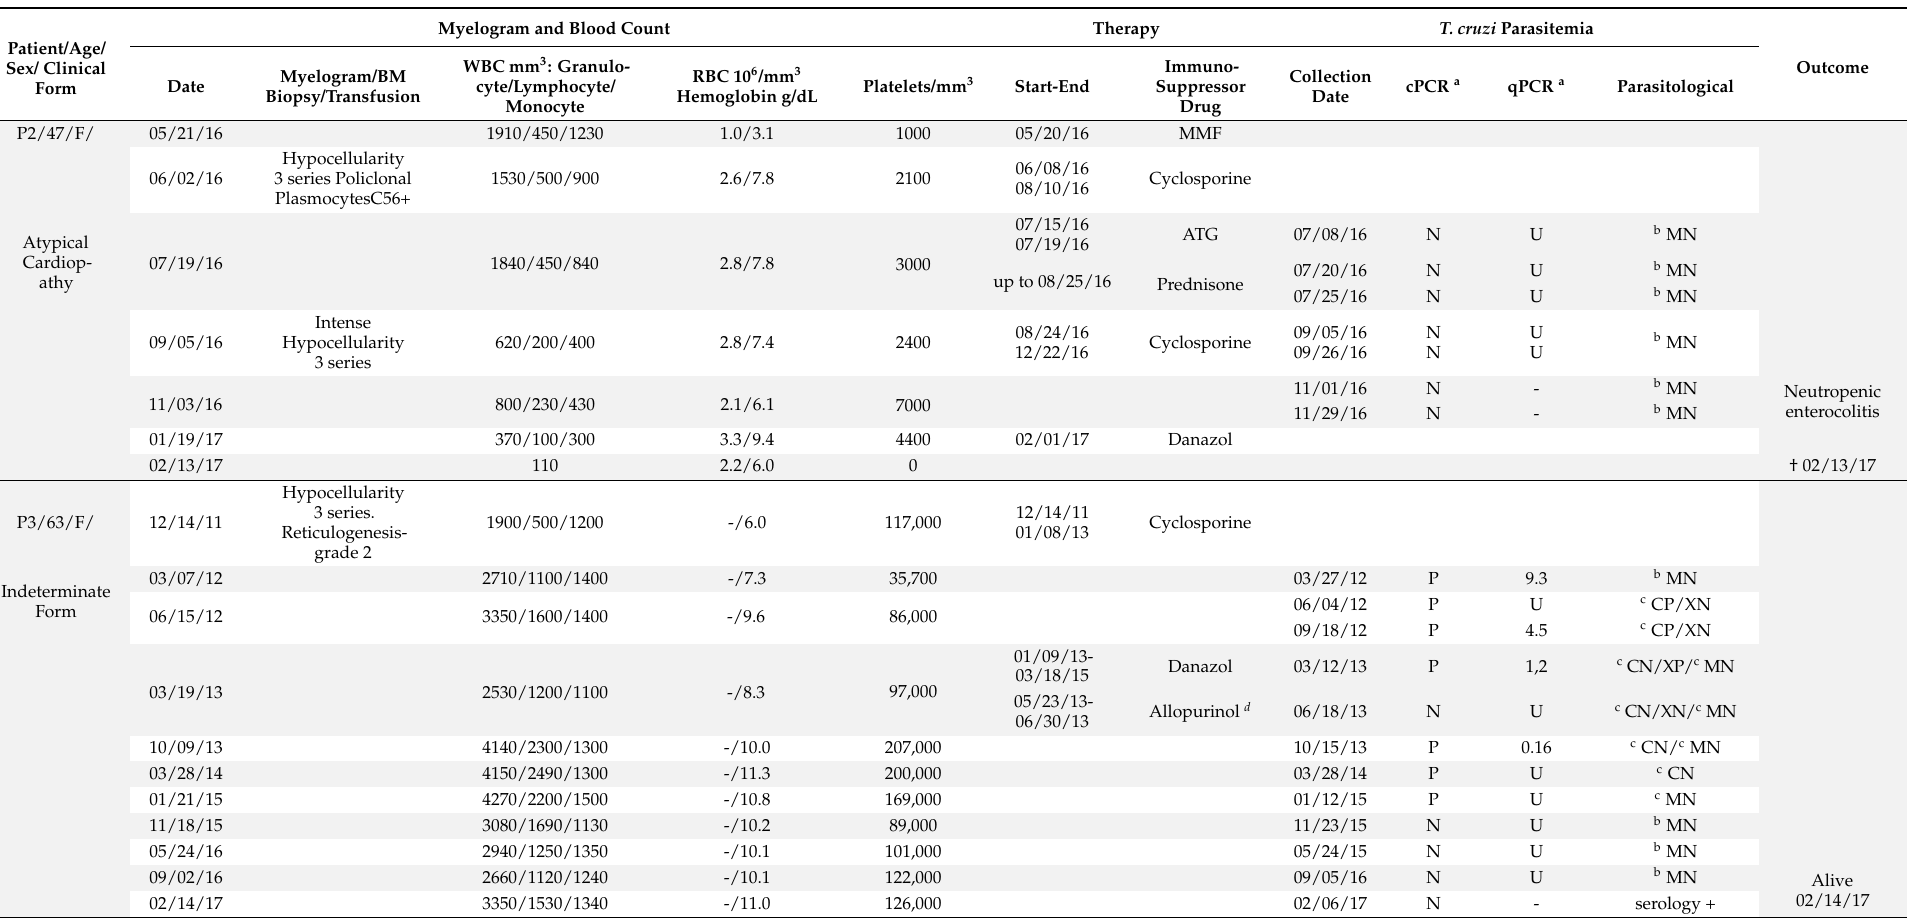
Table 2. Follow-up of two AA patients with chronic Chagas disease (P2, P3), according to hematological parameters, parasitemia, and the immunosuppressive and antiparasitic